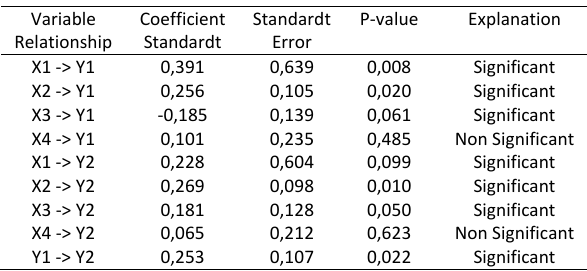
Table 5: Path Table 5. Path coefficient